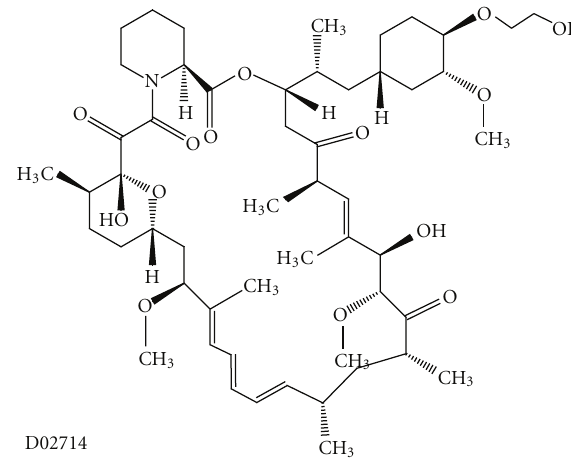
Figure 10: Molecular structure of everolimus extracted from KEGG database [9].